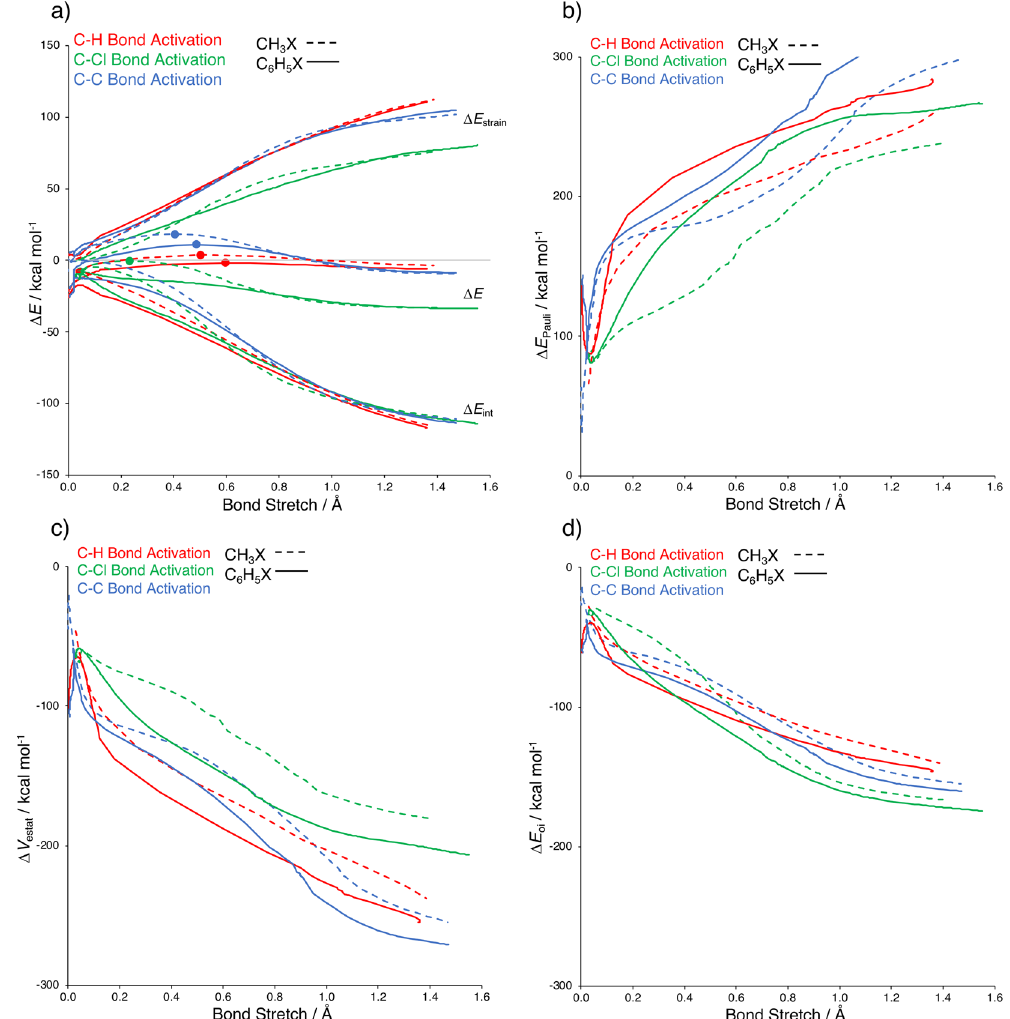
Figure 5. ( a ) Activation strain diagram comparing the oxidative addition of the aliphatic C–X bond versus the arylic C–X bond (X = H, Cl, CH 3 ) by a Pd catalyst, where the transition states are indicated with a dot. Energy decomposition analysis terms of the oxidative addition of the aliphatic C–X bond versus the arylic C–X bond (X = H, Cl, CH 3 ) by a Pd catalyst: ( b ) Pauli repulsion; ( c ) electrostatic interaction; and ( d ) orbital interaction. Computed at